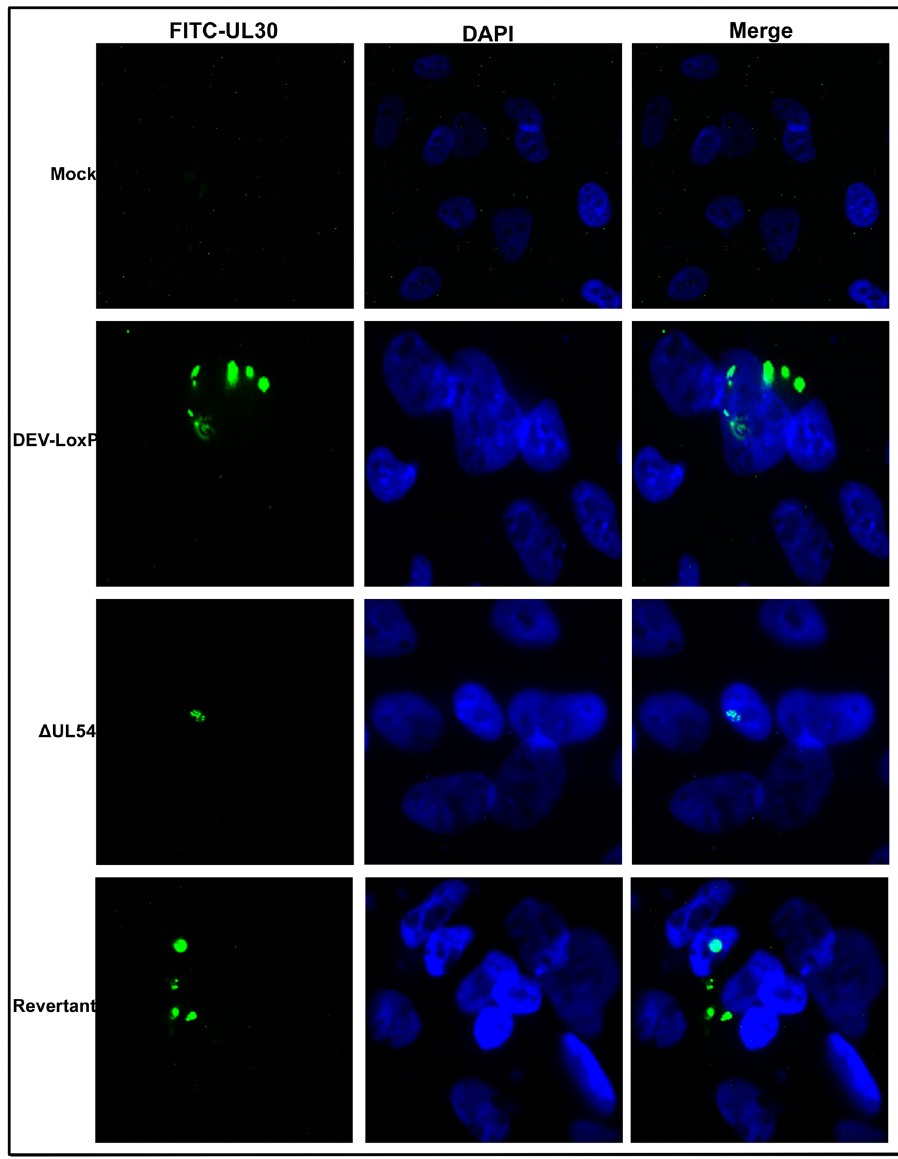
Figure 7. Effect of DEV UL54 on the export of UL30 mRNA. DEFs were infected with DEV-LoxP, DEV- Δ UL54 or DEV- Δ UL54 (Revertant) at 200 TCID 50 and subjected to a FISH assay to visualize the localization of UL30